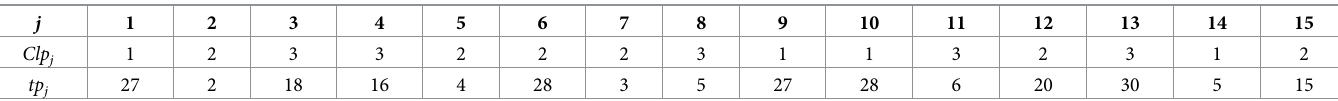
Table 1. Distribution of tp j for each packet Pt j for Example